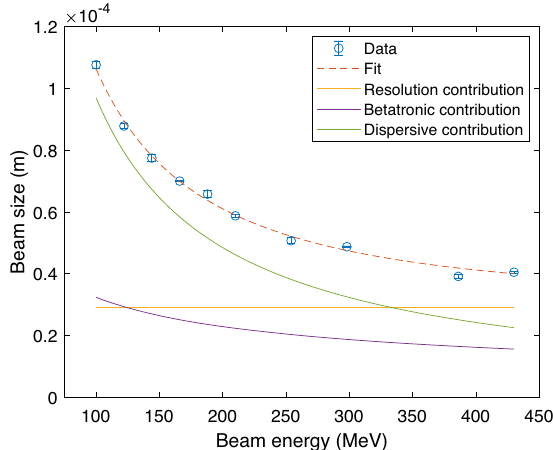
FIG. 7. Measured beam sizes at the profile monitor and corresponding fits for the different contributions for a beam charge of 10 pC. The reconstructed energy spread is 6.5